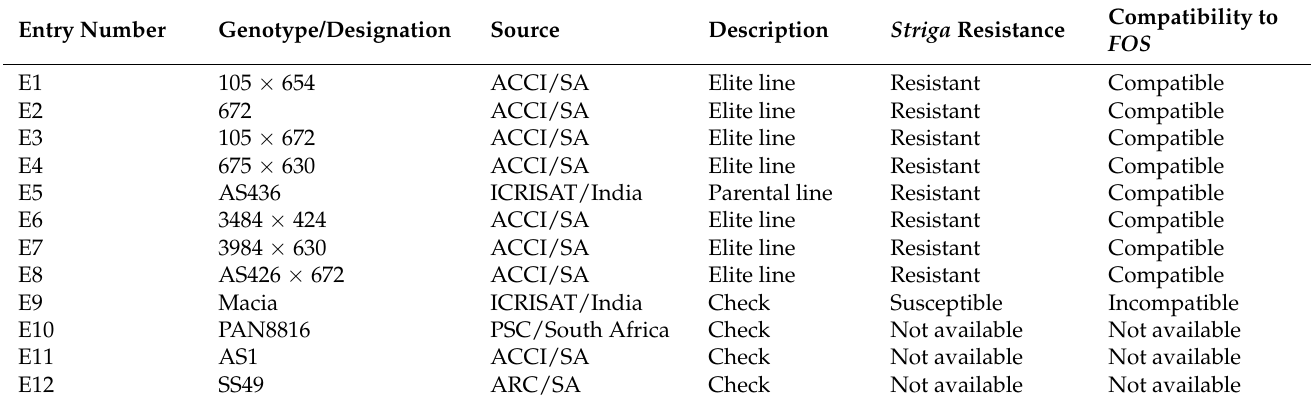
Table 1. List and sources of sorghum genotypes used in the